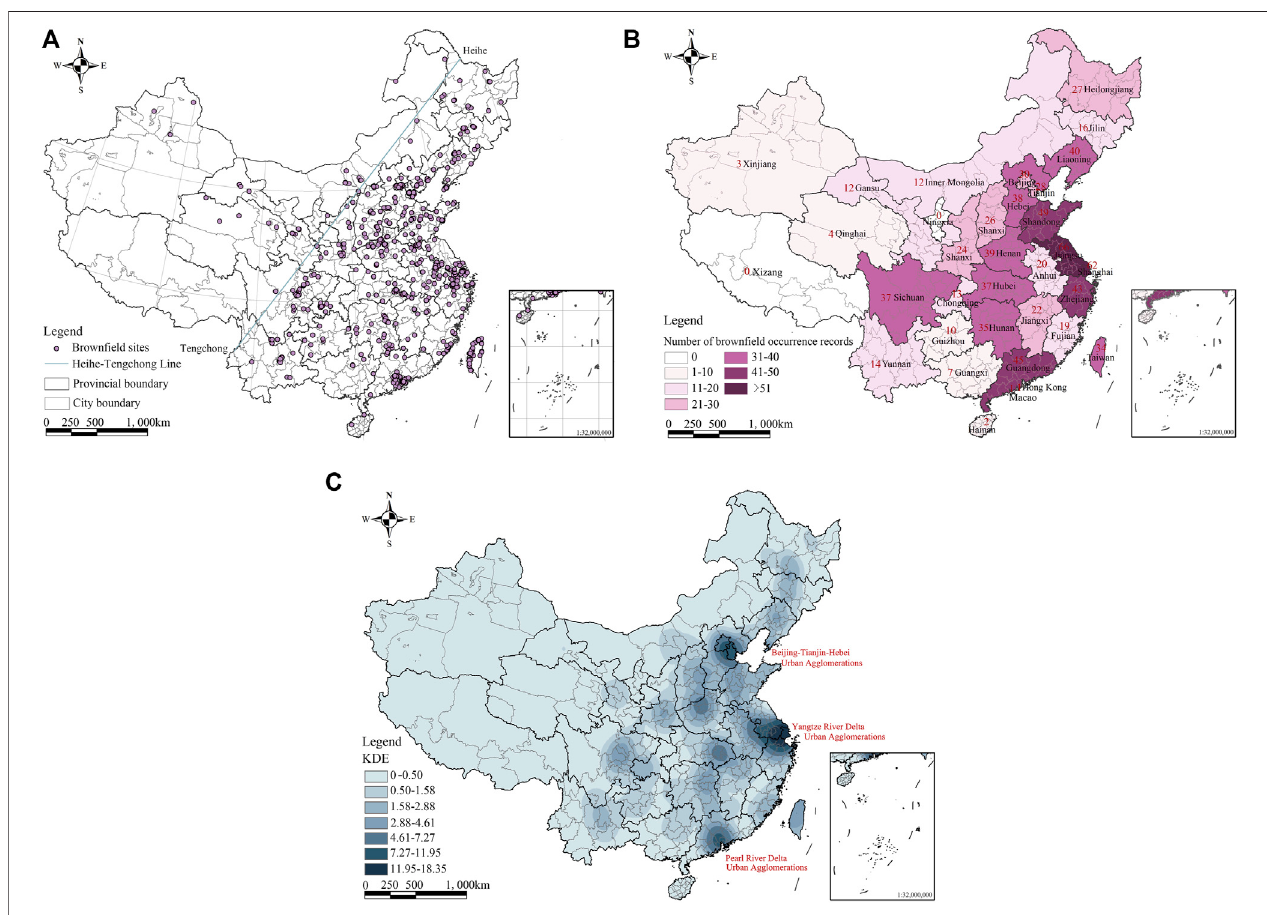
FIGURE 2 | Spatial distribution of brown fi eld occurrence records in China. (A) Locations of brown fi eld occurrence records in China. (B) Number of brown fi eld occurrence records by province-level divisions of China. (C) Kernel density estimation of brown fi eld occurrence records in China.